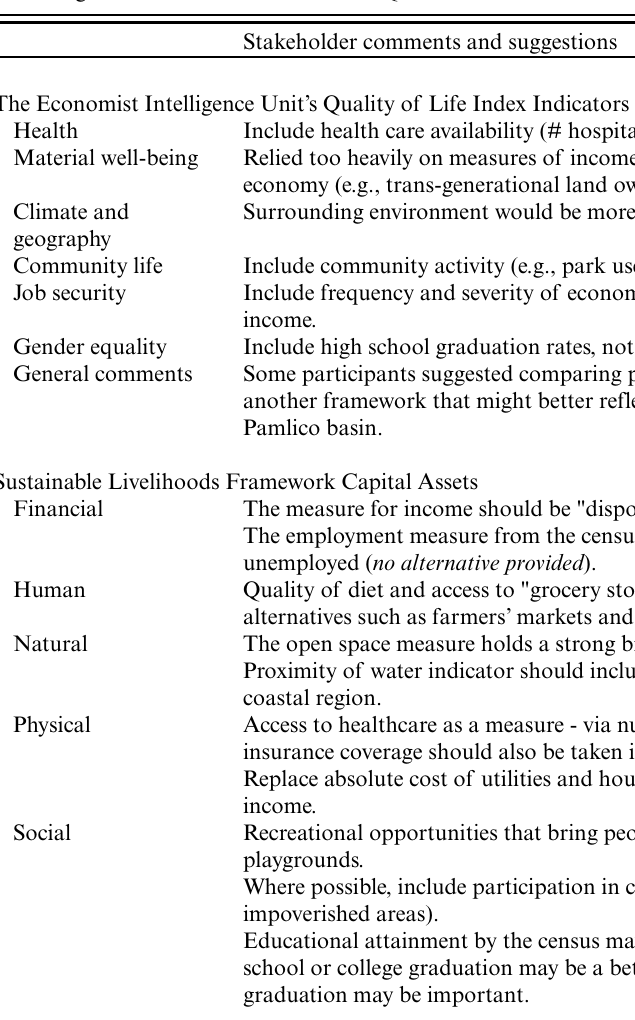
Table 2 . Stakeholder evaluation and feedback regarding the application of The Economist Intelligence Unit’s Quality of Life (QoL) and Sustainable Livelihoods approaches to characterizing human well-being in the Albemarle–Pamlico basin. Comments were not provided for all QoL indicators and some comments were not directed at any given indicator. We have attempted to classify them according to the initial constructs of the